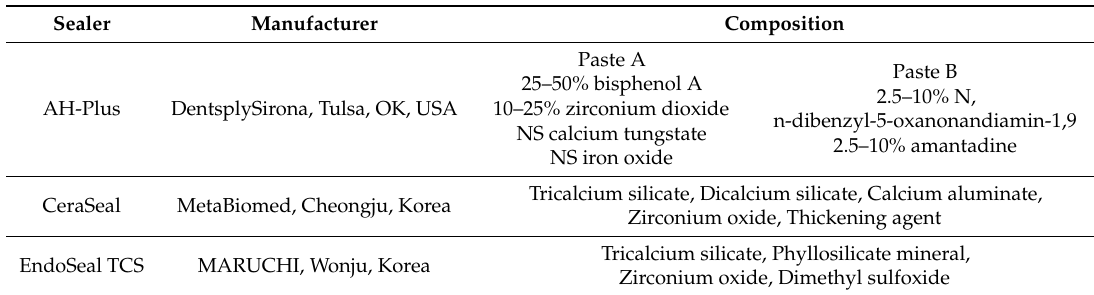
Table 1. The information of the tested sealers in this study. AH-Plus contains bisphenol A, which is a major component of epoxy-resin. CeraSeal and EndoSeal TCS contain several calcium